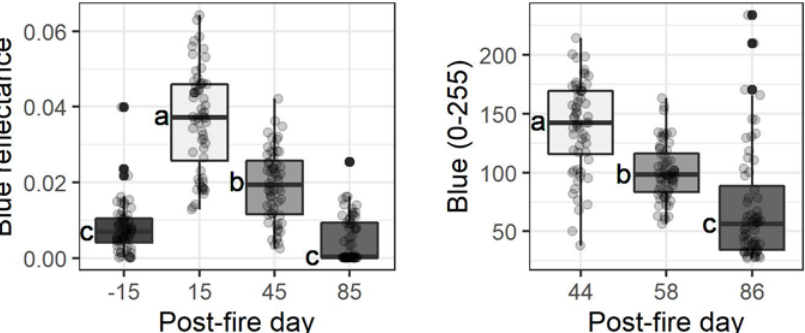
Figure 12. Mesa Fire Sentinel-2 blue reflectance is on the left and UAS blue is on the right. Lower case letters indicate statistically ( p < 0.05) different mean blue values within an image type from the mixed model.